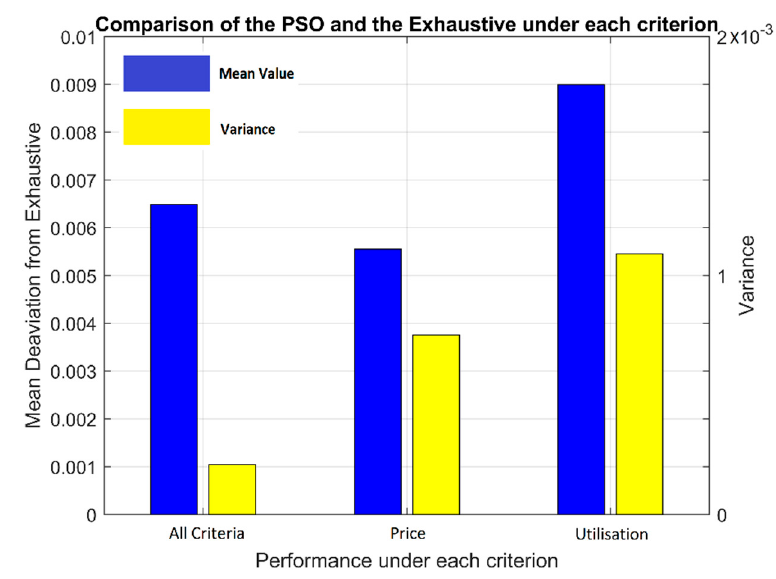
Figure 16. Comparison between the exhaustive search and the PSO under optimisation for all criteria, only price criterion, and only utilization criterion.